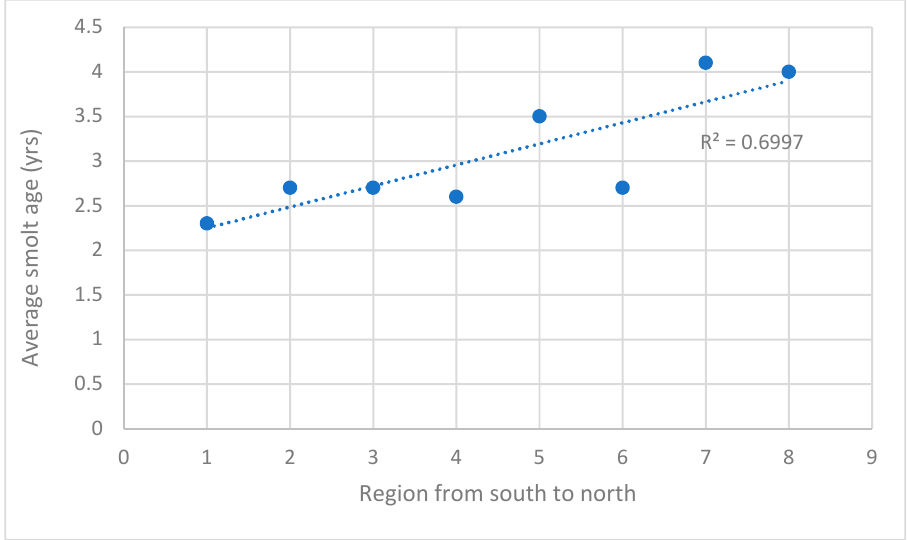
Figure 6. Average smolt age in the eight studied river regions.